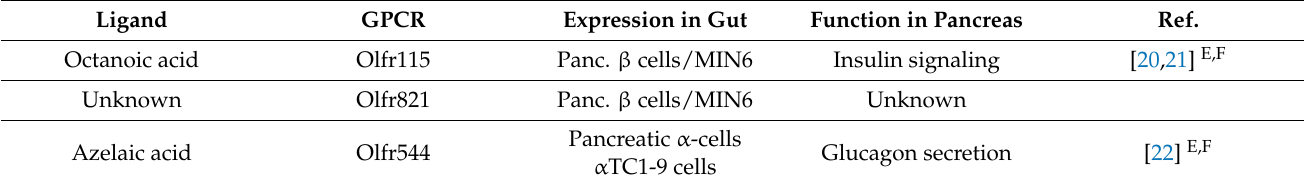
Table 2. Fatty acid ligands with their corresponding ORs, their expression, and potential function in the pancreas.